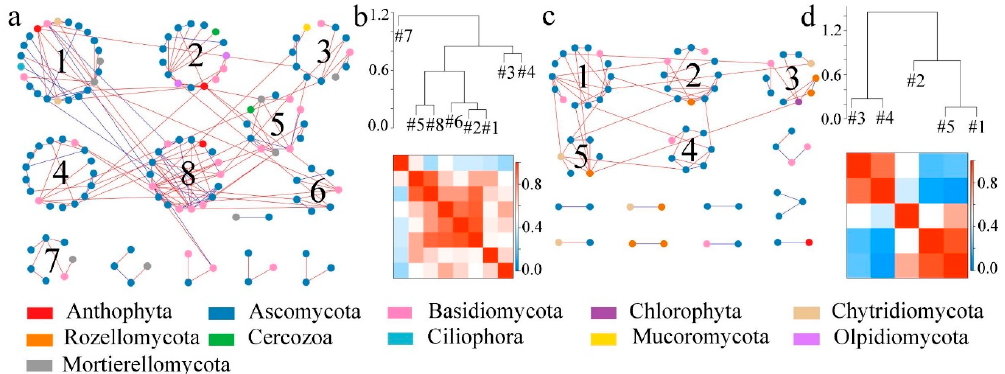
Figure 6. Soil fungal molecular ecological networks and modular eigengene hierarchy structure in DL and PF. ( a ) Soil fungal molecular ecological network in the DL; ( b ) soil fungal modular eigengene hierarchy structure in the DL; ( c ) soil fungal molecular ecological network in the PF; ( d ) soil fungal modular eigengene hierarchy structure in the PF.